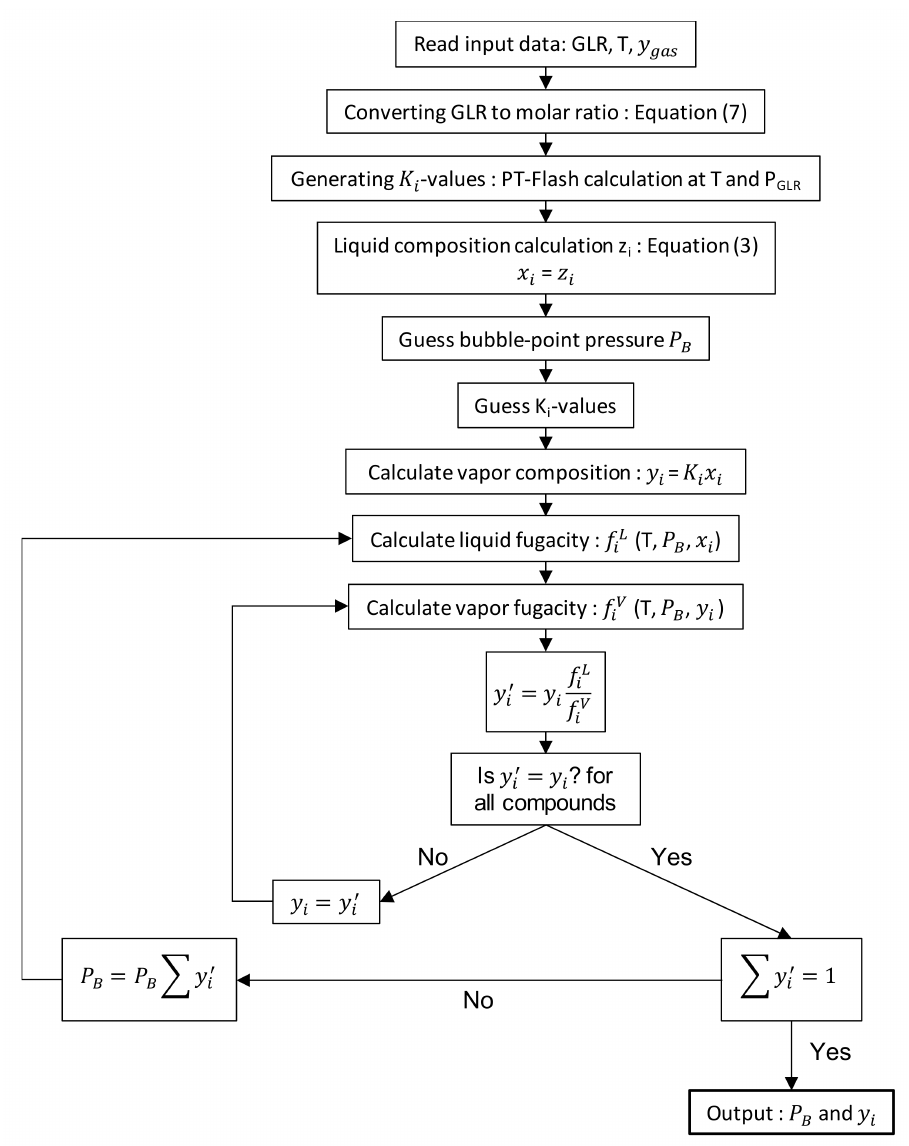
Figure 2. Algorithm for calculating the bubble point pressure of geothermal